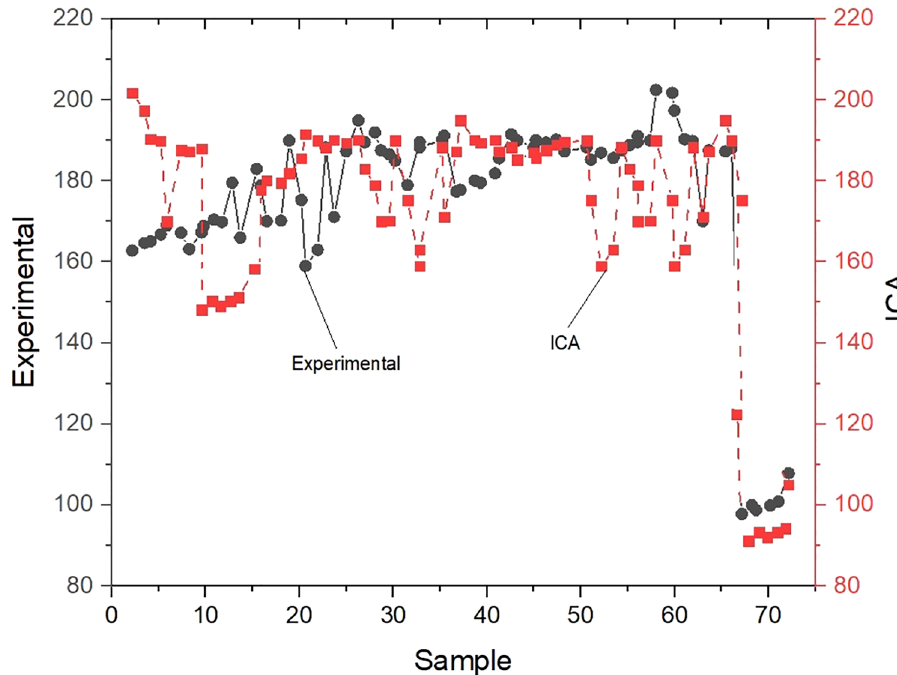
Fig. 9 Comparison between the imperialist competitive algorithm data and the real data in the tensile